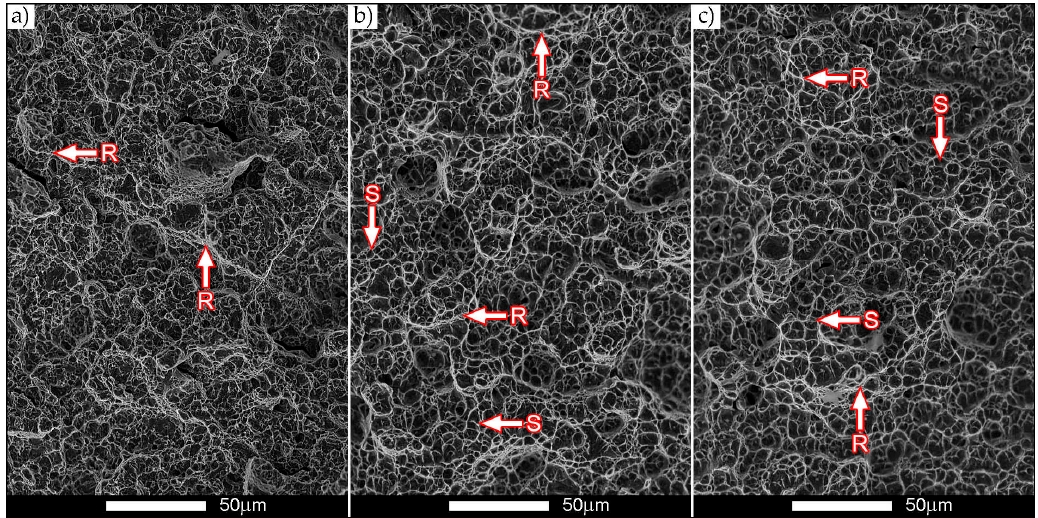
Figure 27. SEM images of fracture surfaces of Hardox Extreme welded joints after heat treatment, shown in Figure 24, after impact testing at +20 ° C. ( a ) Area marked with the frame A2; ( b ) area marked with the frame B2; ( c ) area marked with the frame C2. R—“river” system; C—microcracks with fine steps; S—“scaly” steps. Scanning microscopy, unetched. Metals 2019 , 9 , x FOR PEER REVIEW